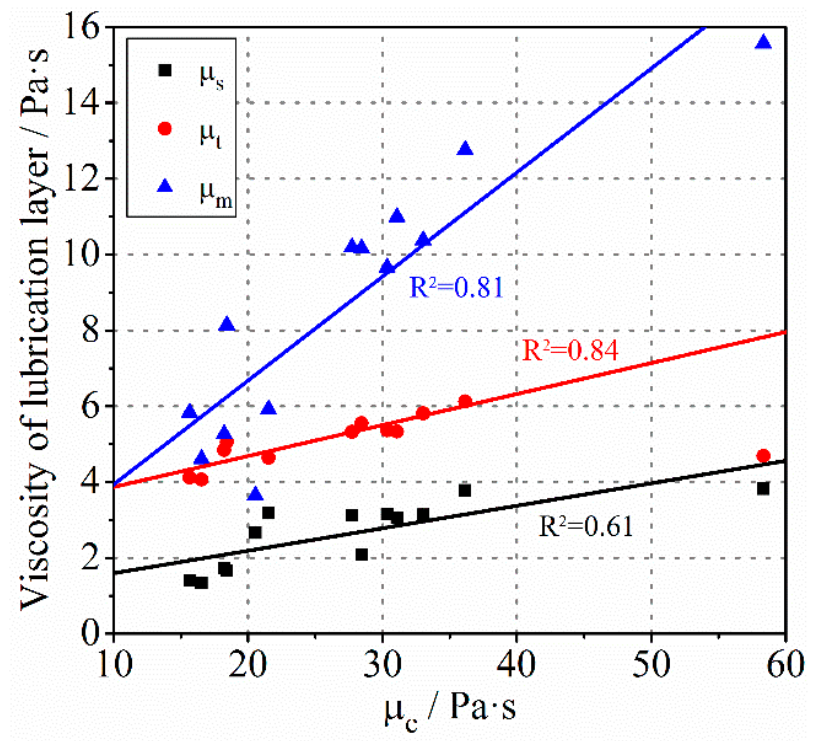
Figure 4. The relationship between the viscosity of concrete and the viscosity of the lubrication layer.